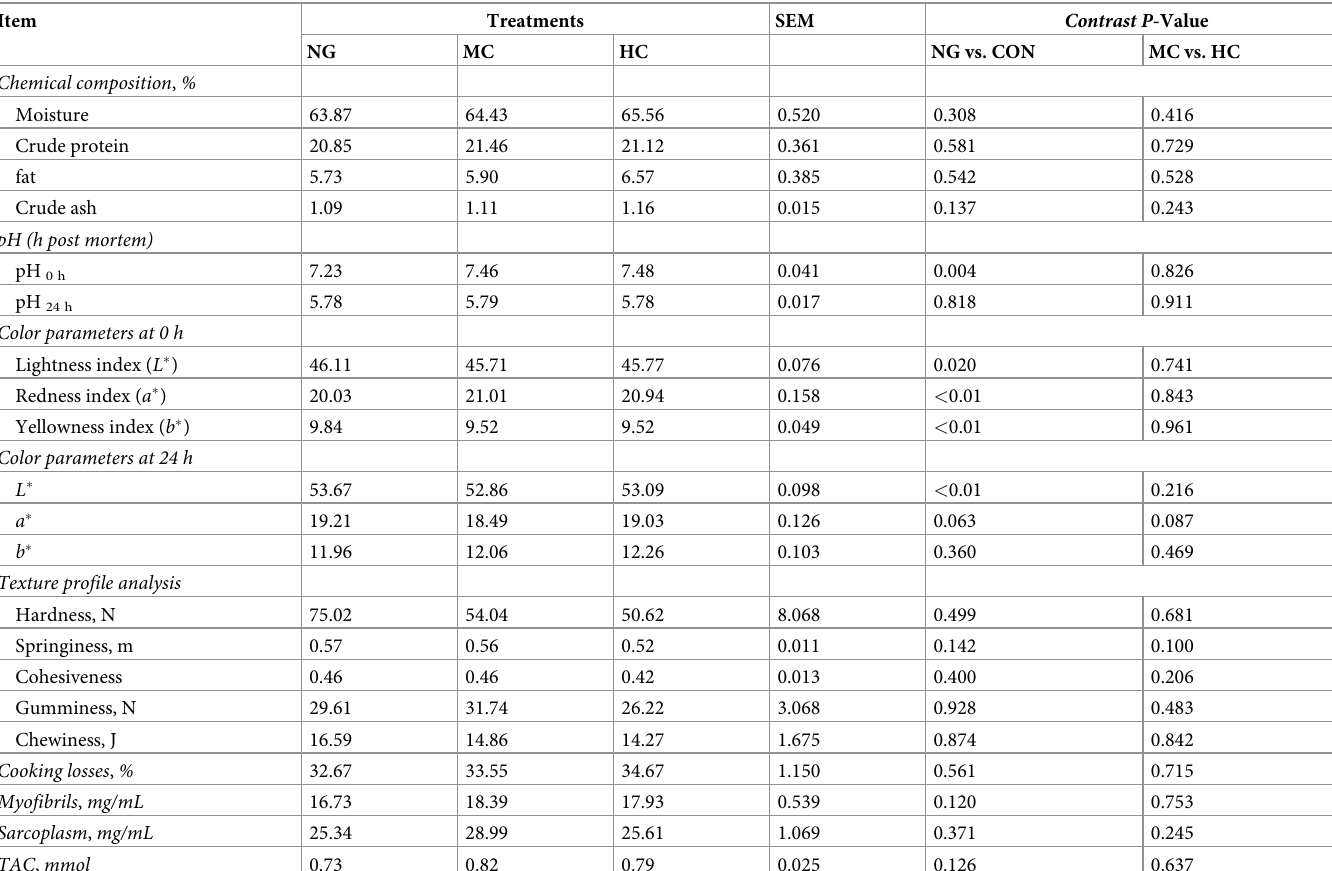
Table 5. Longissimus dorsi muscle characteristics of lambs from different production systems.